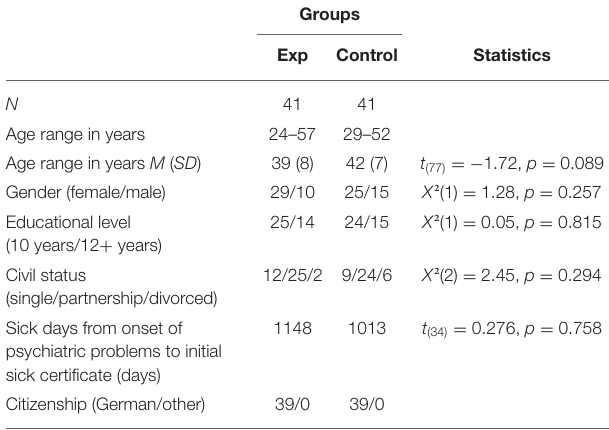
TABLE 2 | Sociodemographic information, separately for participants in the experimental and control group.